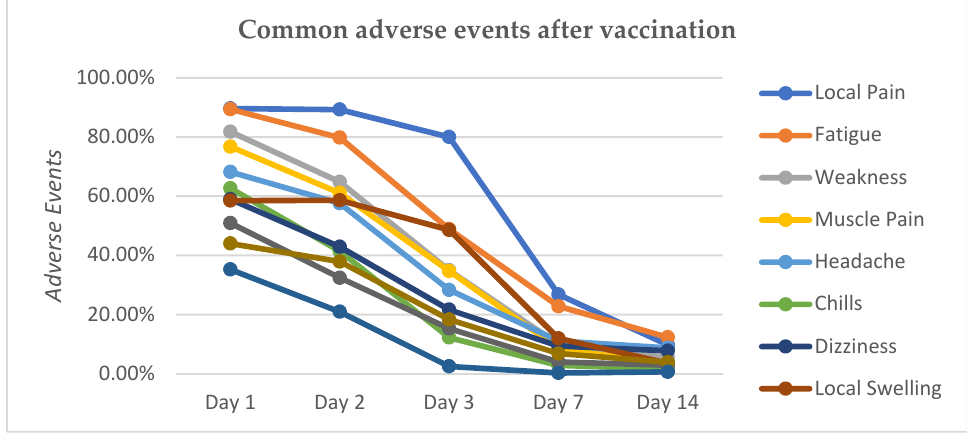
Figure 1. Trend of physical adverse events among HCWs after COVID-19 vaccination on day 1, day 2, day 3, day 7, and day 14 of measurement.